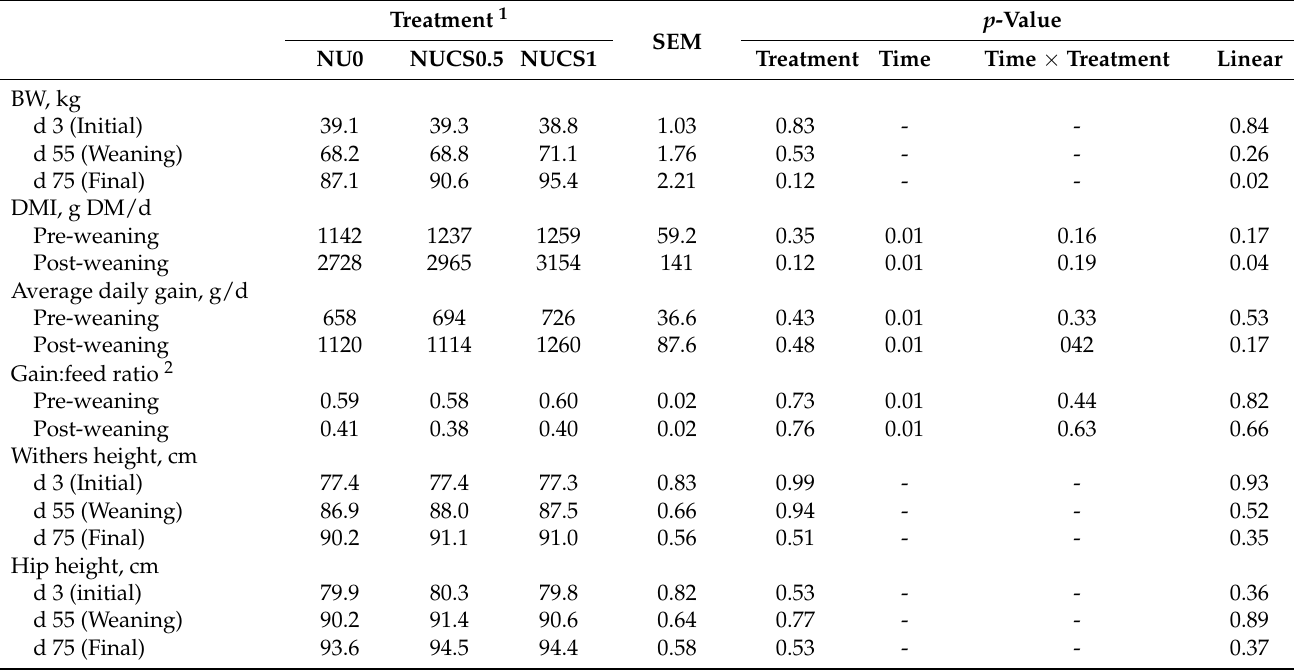
Table 2. Effects of nucleotide (NU) supplementation to whole milk on productive performance of Holstein calves.